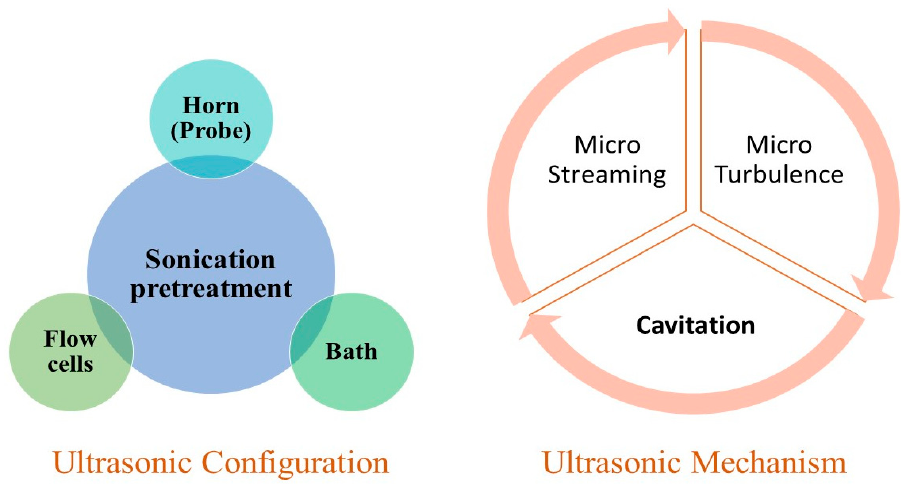
Figure 4. Ultrasonic pretreatment configuration and mechanism requirements.